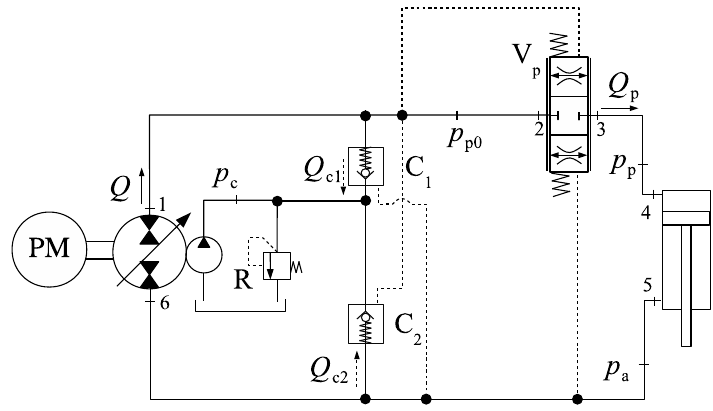
Figure 13. Circuit with an inline throttling valve.